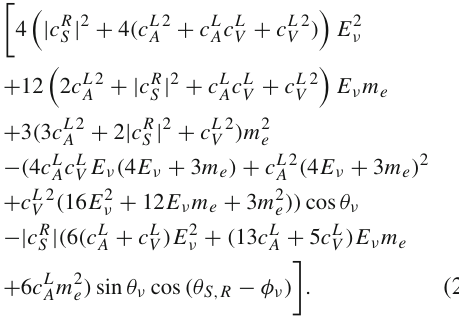
tion. In both cases the maximal values of the A y and A θ are equal to 0 . 0794, and these are obtained at y max ≈ 0 .